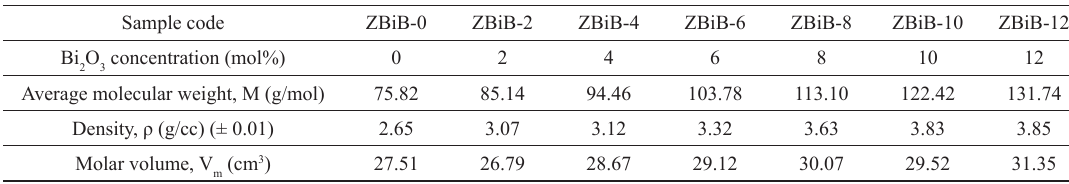
Table 1. Physical parameters of the synthesized glass samples. Sample